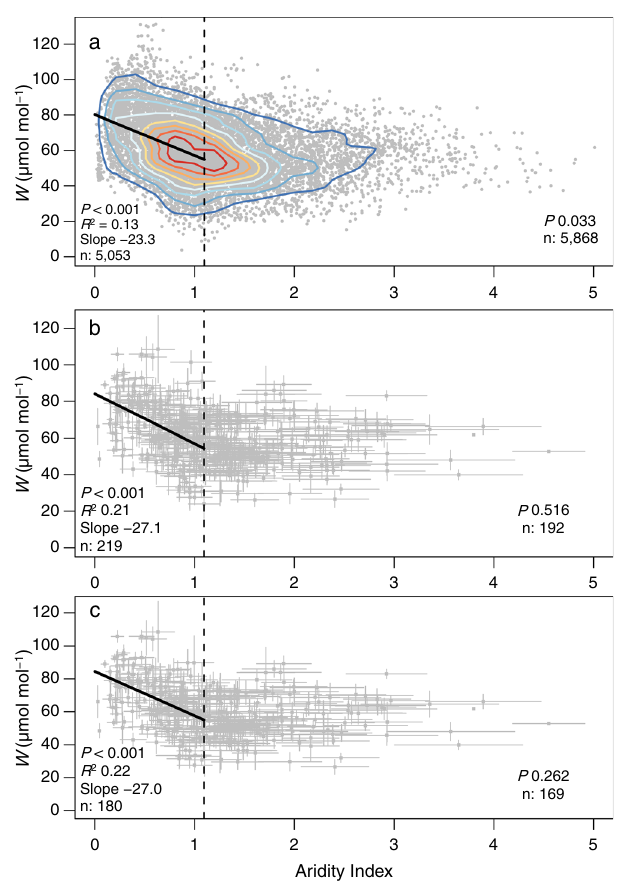
Fig. 2 Relationship of intrinsic water use ef fi ciency ( W , µ mol mol − 1 ) to aridity index (precipitation/potential evapotranspiration, mm mm − 1 ), 1965 – 2015. P values are from linear regressions using F-statistics. a All observations of W , as derived from individual tree rings. b Observations binned by sample tree. c Observations binned by study site. The breakpoint in AI is indicated by a broken line (see Methods for description of breakpoint analysis). In Panel a , the density of data points is indicated via lines demarking 10% increments in the total observations (from 20 to